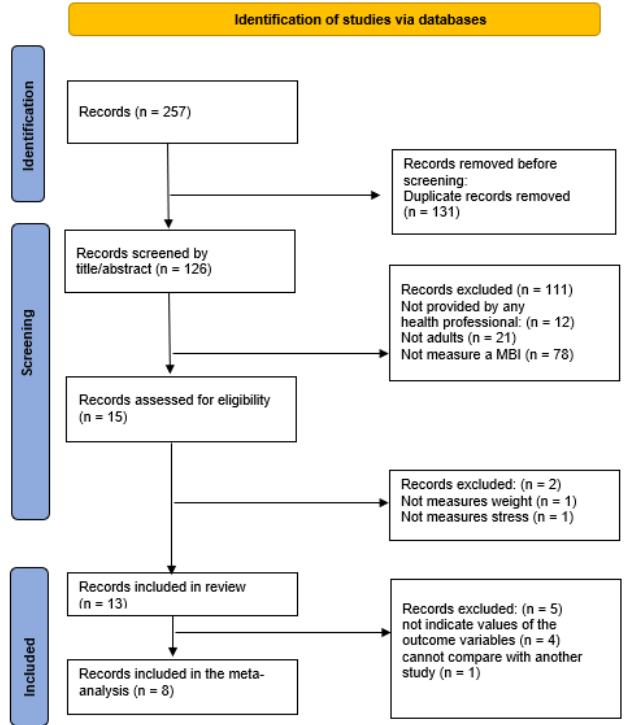
Figure 1. PRISMA flow diagram.